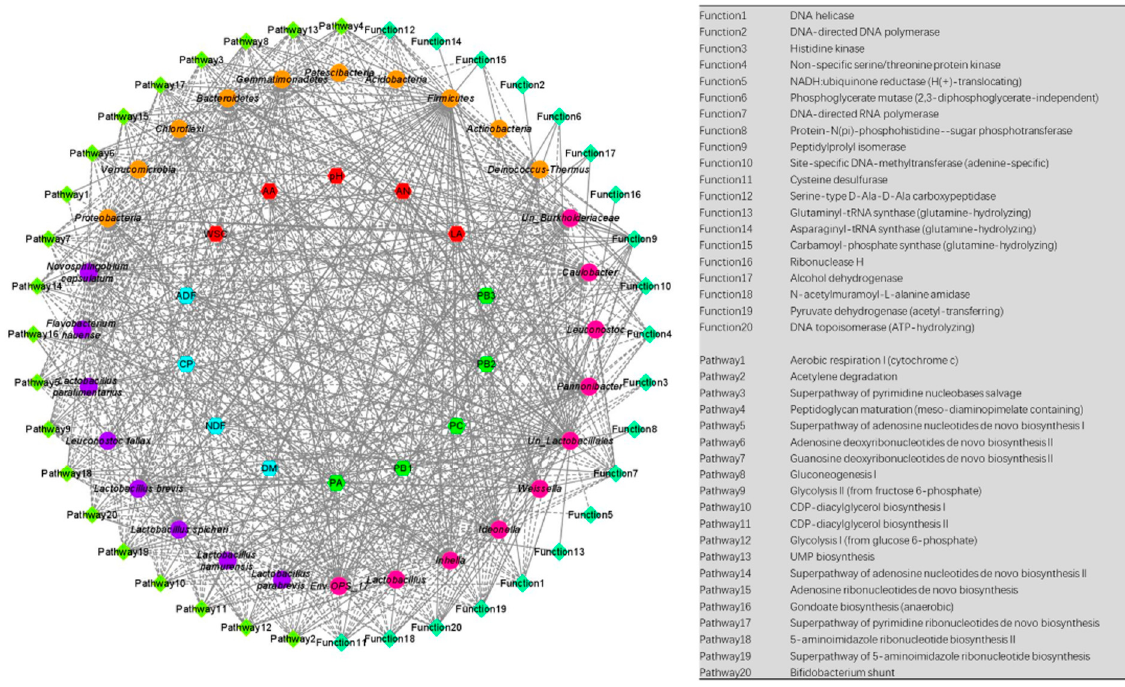
Figure 5. Correlation analyses among various indicators, dominant bacteria, and dominant functions and pathways. The solid line represents a positive correlation, while the dotted line represents a negative correlation.